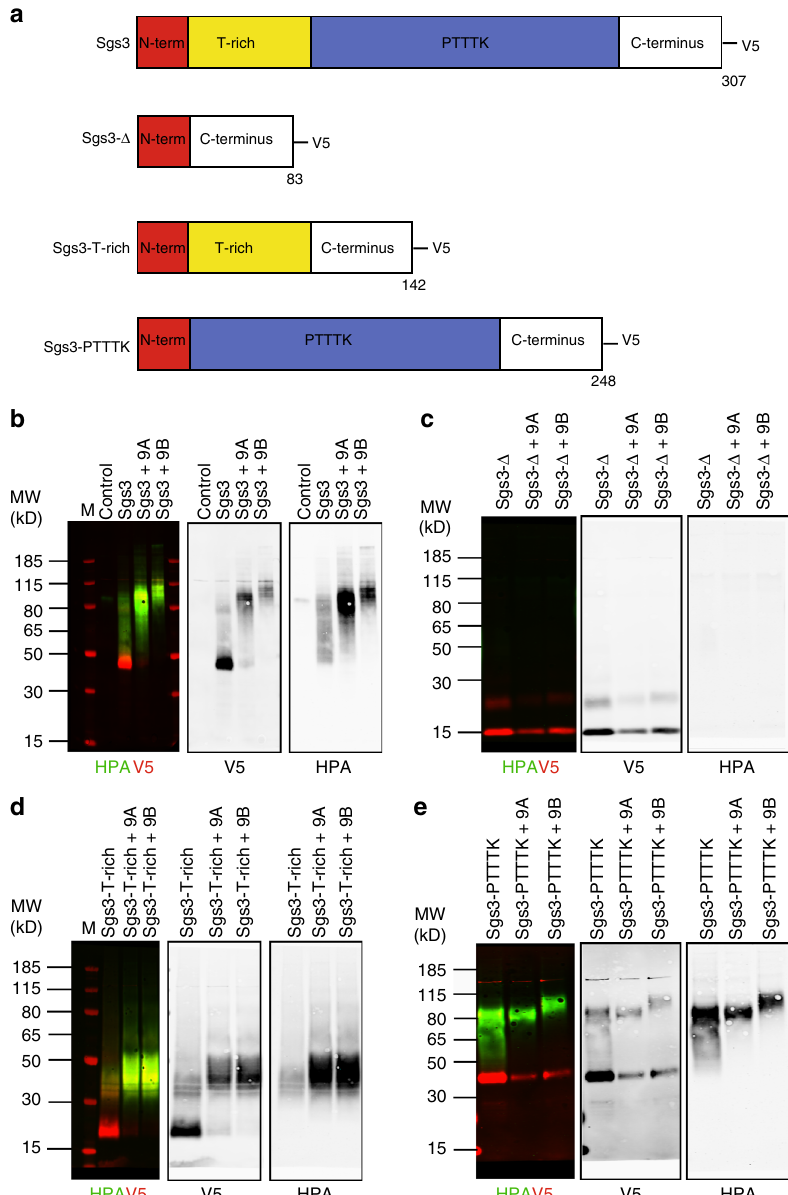
Fig. 4 Differential glycosylation of Sgs3 by PGANT9A and PGANT9B. a Diagrams of full length Sgs3 and Sgs3 deletion constructs are shown (sequences are shown in Supplementary Fig. 2a). The N-terminal region is shown in red and the two distinct regions predicted to be glycosylated are shown in yellow (T-rich) and blue (PTTTK). The C-terminal region is shown in white. All constructs are V5-tagged. b Western blots of puri fi ed proteins from S2R + cells transfected with empty vector (control), the full length Sgs3 construct (Sgs3), Sgs3 with a plasmid expressing PGANT9A (Sgs3 + 9A) or Sgs3 with a plasmid expressing PGANT9B (Sgs3 + 9B). Westerns were probed to detect the Sgs3 protein (V5; red) and changes in glycosylation (HPA; green). Westerns of puri fi ed proteins from similar transfections using the Sgs3- Δ construct ( c ), the Sgs3-T-rich construct ( d ), and the Sgs3-PTTTK construct ( e ) are also shown. Representative images from three independent experiments are shown. Size markers are shown to the left of each